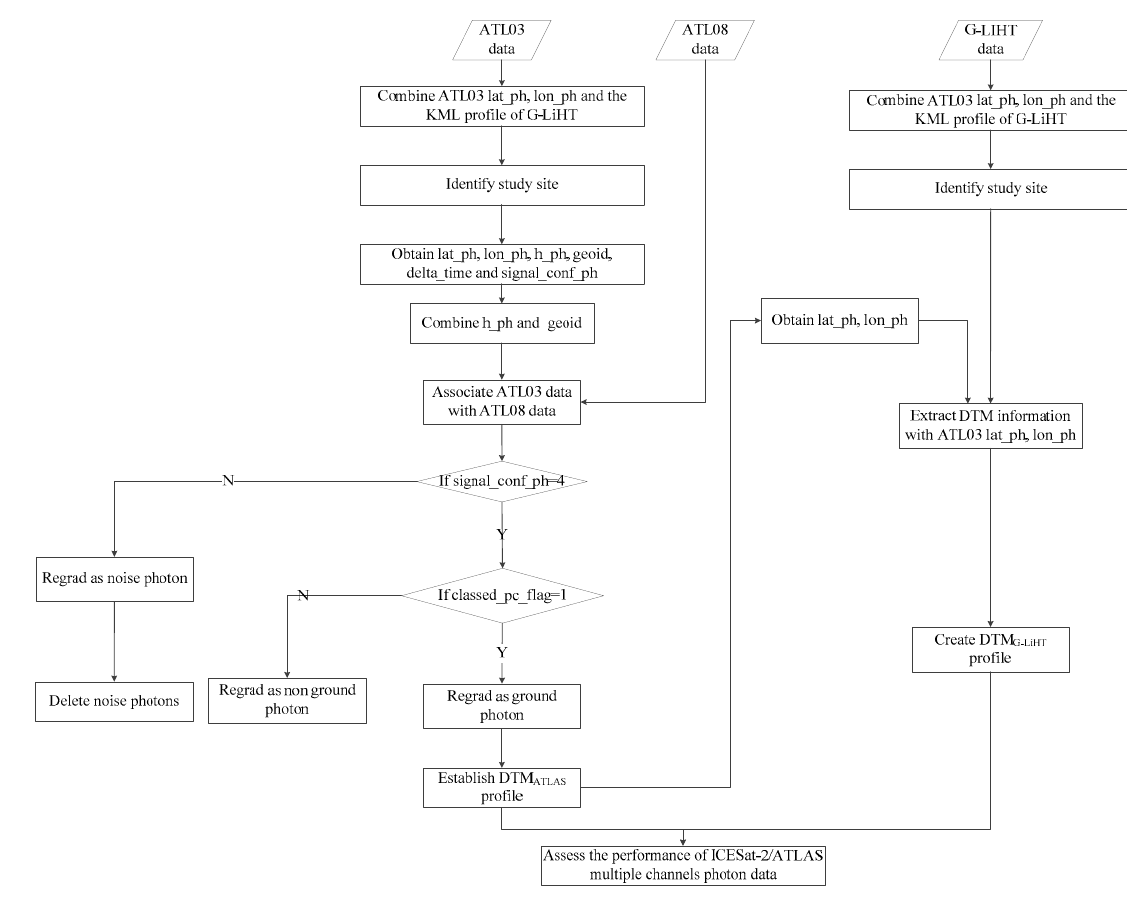
Figure 4. The flowchart of the analysis process.